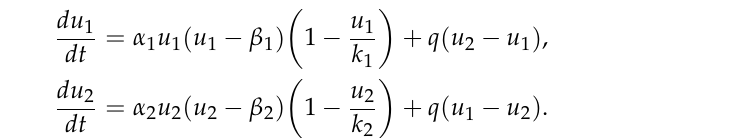
Figure 3.8: Isoclines of the Model Allee effect, q = 0 . 5 Figure 3.9: Isoclines of the Model Allee effect, q = 1